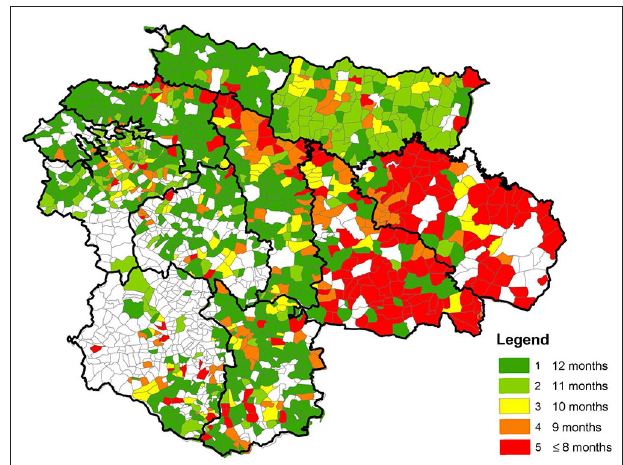
FIGURE 3 | Source water sustainability